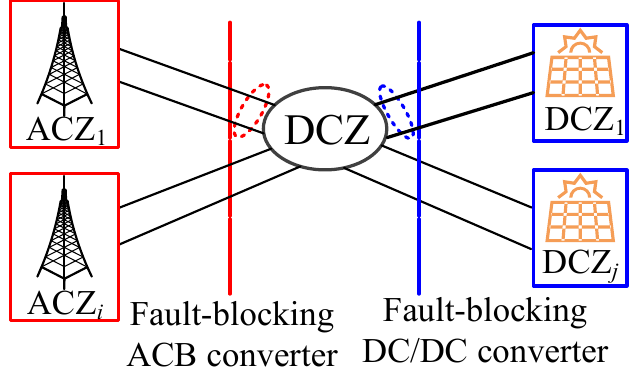
Figure 6. Schematic diagram of zonal ‐ based protection strategy for DC